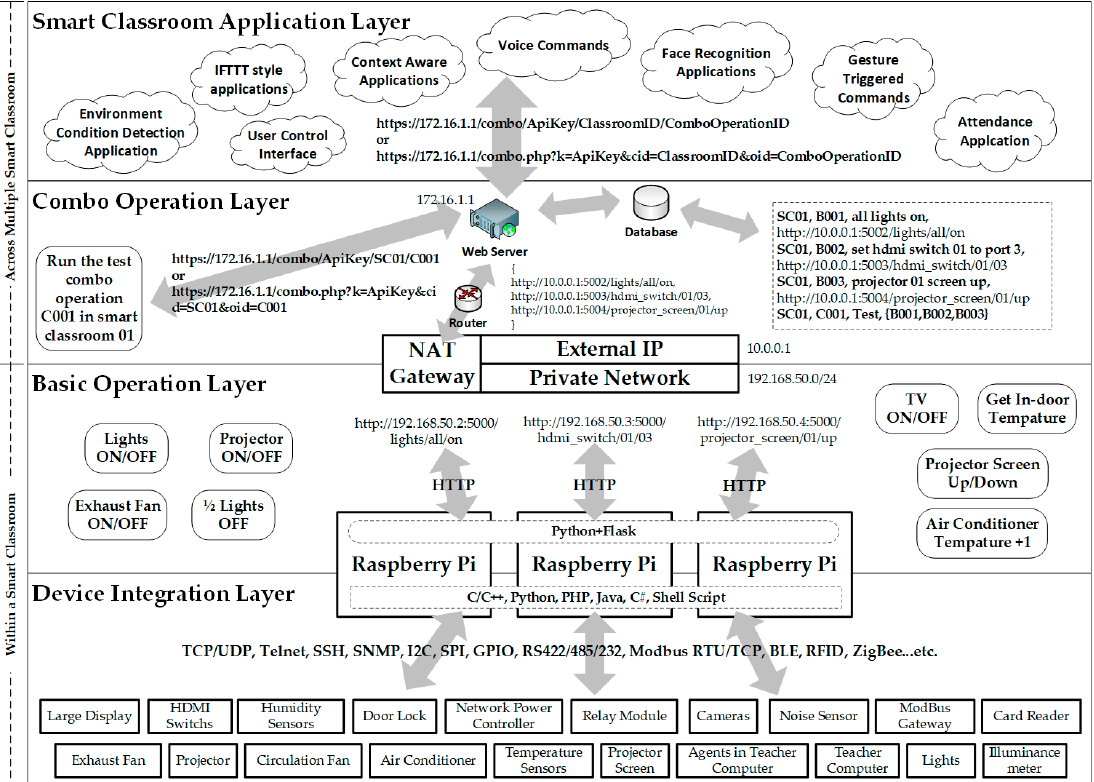
Figure 8. The smart classroom technology integration model.